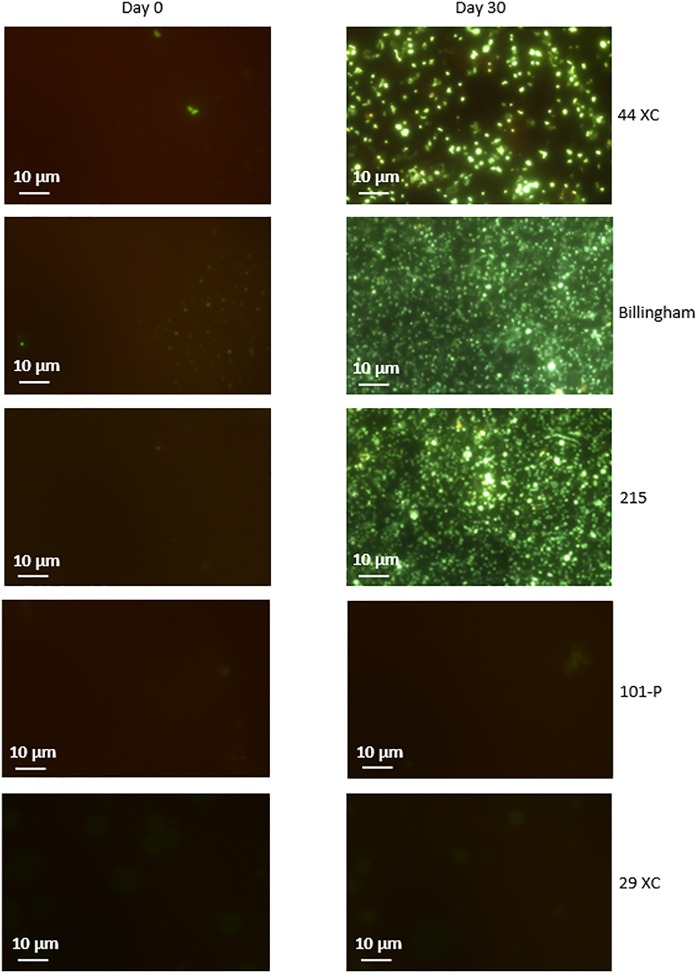
Microscopy of cultures in filtered brines containing nutrient broth inoculated with the same brines unsterilized. 44XC, Billingham and 215 all displayed dense enrichments after less than 30 days. 29XC and 101-P showed no growth. SYBR gold nucleic acid stain was used to visualize cells. Some images display regions of none specific stain binding to clay particles such as in 101-P.